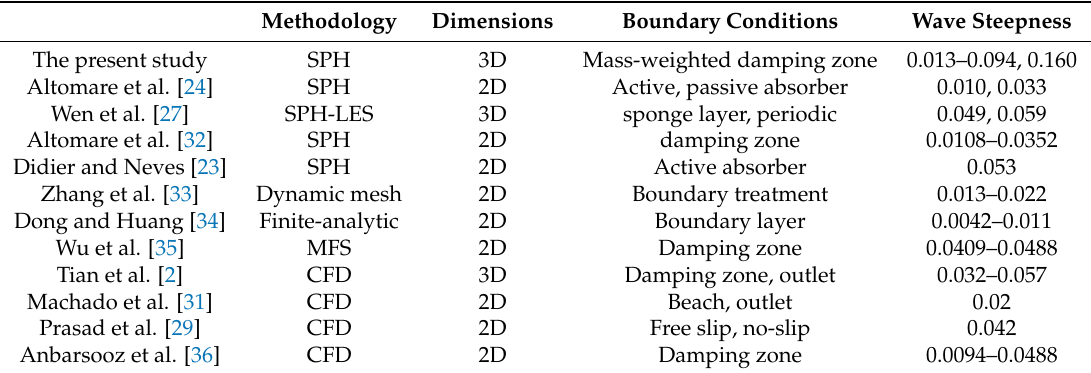
Table 1. Comparison of numerical wave tank